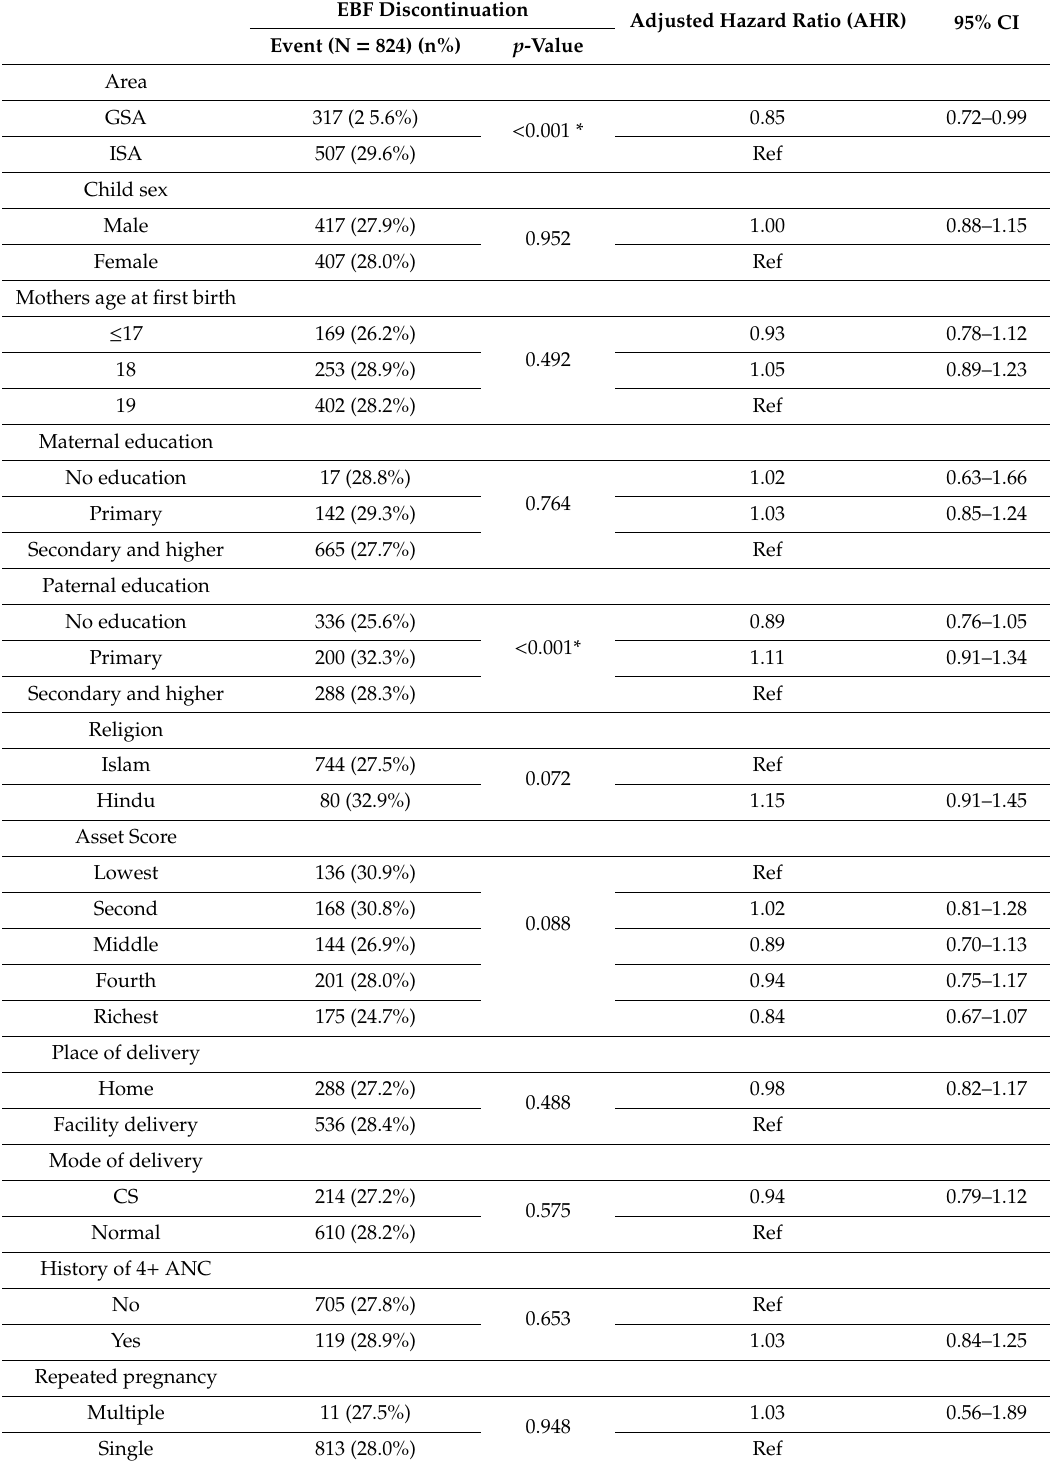
Table2. Factorsassociatedwithexclusivebreastfeeding: